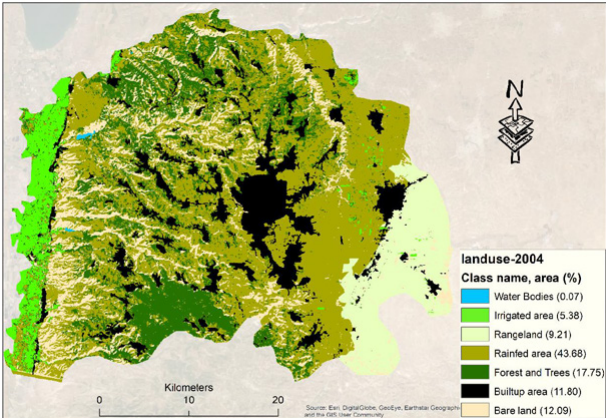
Fig. 3c: Land use in Irbid governorate in 2004